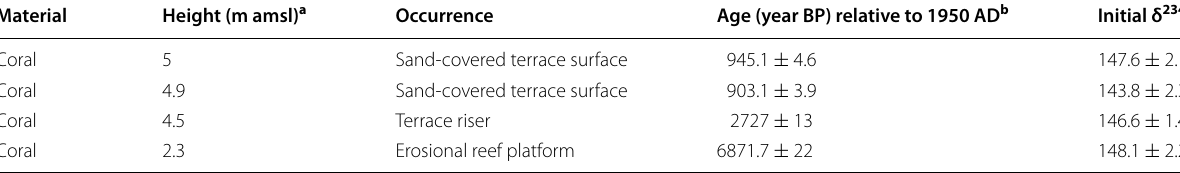
Table 3 Geomorphologic data of survey site in Badoc Island, Ilocos Norte